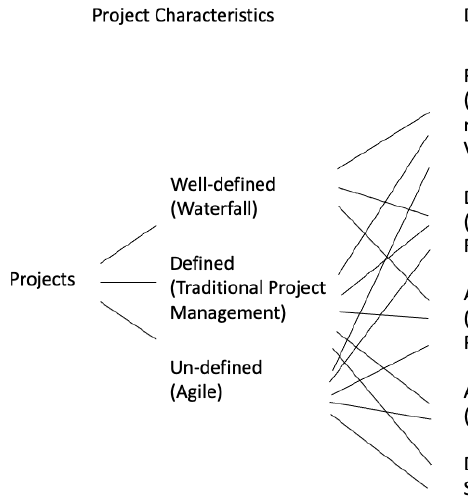
Figure 2. Blended design process, i.e., the skewed V-diagram [36]. The blended design process [36] comprises phases of opportunity analysis, require- ment analysis, specification, concept design, system analysis, prototyping, testing, pro- duction planning, and opportunity realization. The phases follow an adapted timeline from the classic V model [37], but this is skewed to take account of the increased resources associated with some activities. Each phase of the blended design process is connected to a corresponding phase to indicate and prompt consideration of the relevant aspects, be it from the initial design activity or detailed planning. The phases are also connected to ad- jacent phases to prompt and indicate iteration with flows back and forth of information and revisiting of ideas and decisions as new information emerges. Typical design pro- cesses do not explicitly define sustainability as a principal activity or function in different stages. Instead, the classifications used with the model description are broad and generic. This could be viewed as a benefit or a risk, depending on whether the individual designer or company concerned is willing or able to apply considerations of sustainability and the associated tools and significant resources available. For example, in requirements analysis, the need for a product, service, or system to perform to a prescribed level of sustainability could be recognized and addressed. In specifications, these levels can then be qualified and quantified as appropriate, for example, ensuring compliance with relevant national